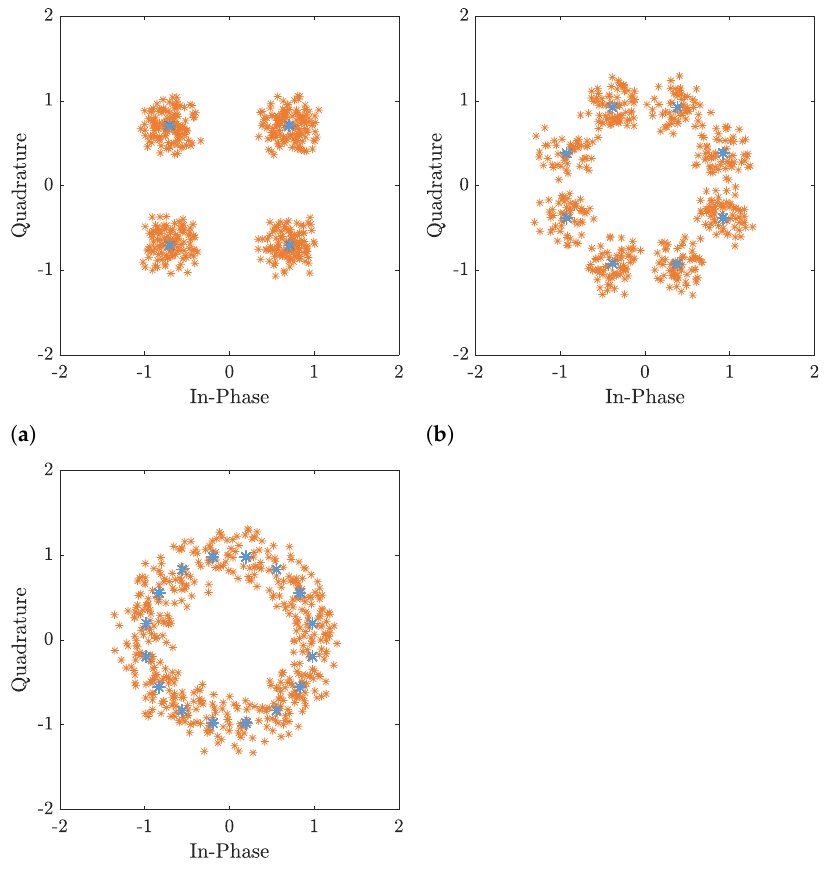
Figure 10. A constellation of transmitted symbols (blue) and received symbols in the presence of the partial band noise (PBN) jammer (orange), for ( a ) 4–PSK, ( b ) 8–PSK, ( c ) 16–PSK modulations, no AWGN, and SIR = 10 dB.